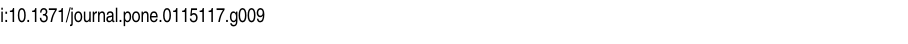
Fig. 9. d’ as a function of visible body part and figure orientation for the rowing action in Experiment